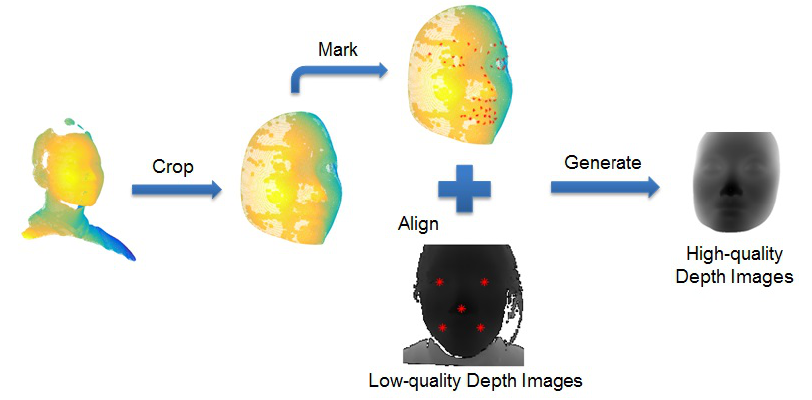
Figure 4. Procedure of generating high-quality depth